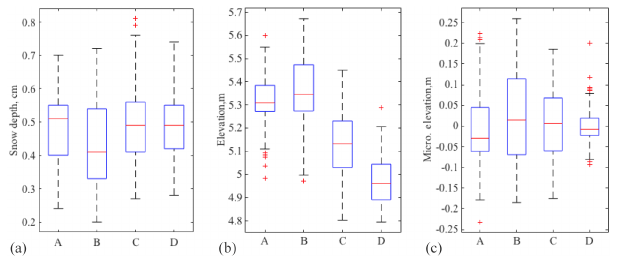
Figure 6. Correlation coefficients between snow depth and topo- graphic metrics as a function of the wavelet scale: (a) the micro- topographic elevation and (b) the wind factor of macrotopography. The different colors represent different plots (plots A–D) or all the data (All). Each dash line represents the scale that maximize the magnitude of the correlation